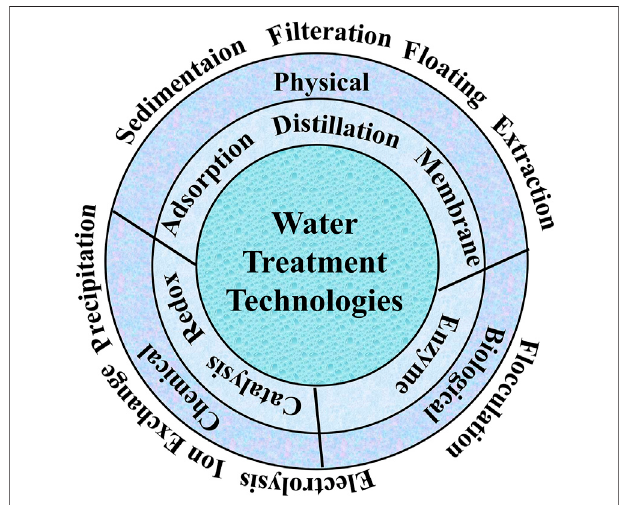
FIGURE 4 | Common methods for water treatment